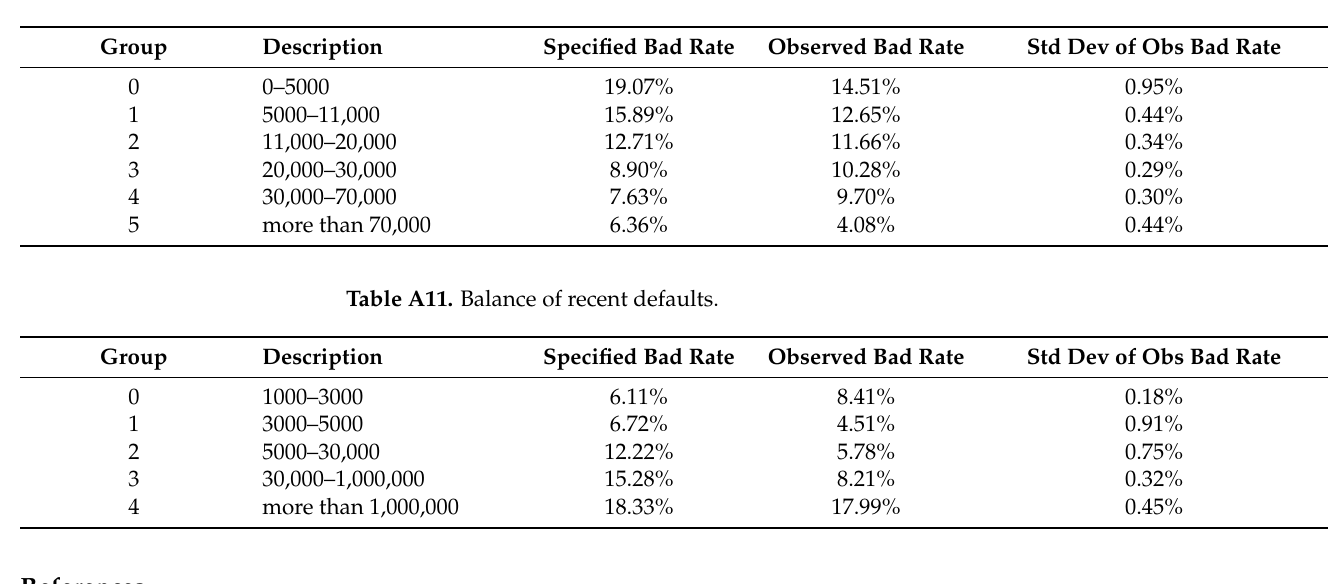
Table A10. Income.